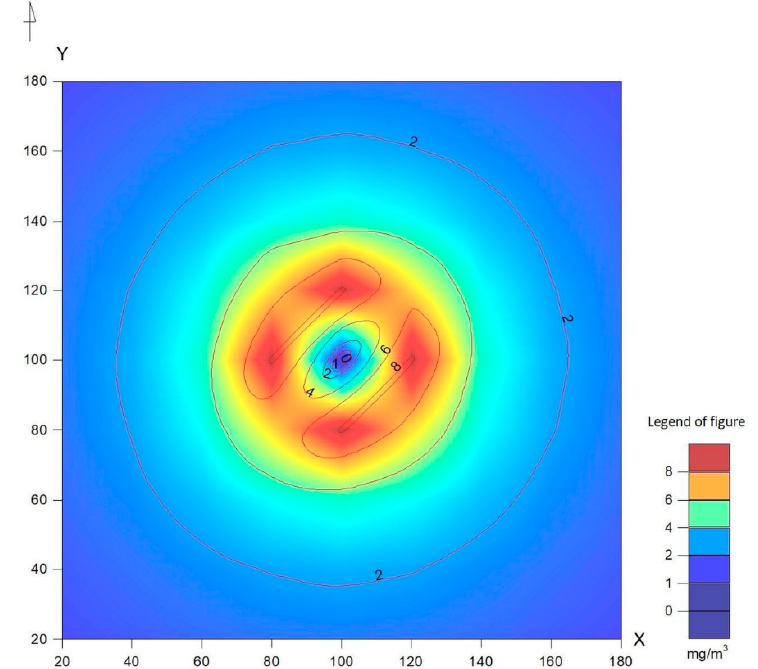
Figure 2. Average annual concentrations for methane (CH 4 ) emissions at a height of 10 m. Note: X axis—component of the distance from the emitter to the point for which the calculations were made, parallel to the wind direction; Y axis—component of the distance from the emitter to the point for which the calculations were made, perpendicular to the wind direction.